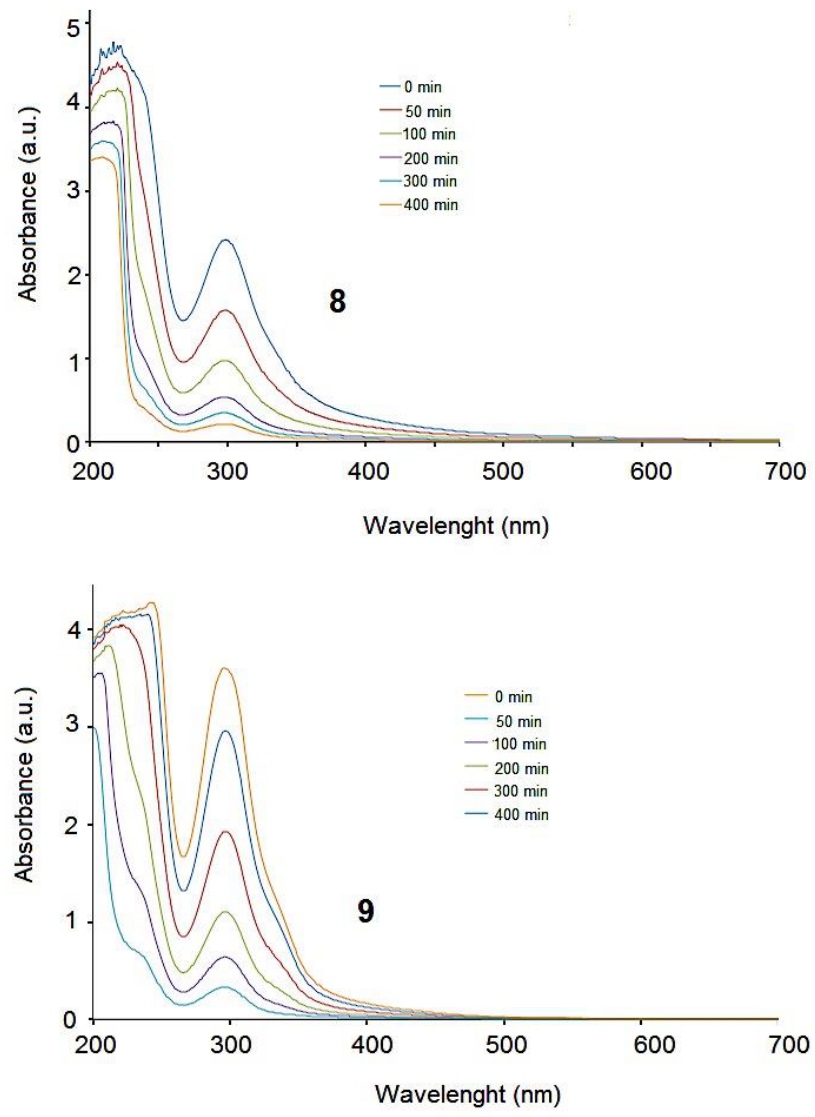
Figure 3. Ultraviolet (UV) spectra showing drug release from conjugates 8 and Figure 3 . Ultraviolet (UV) spectra showing drug release from conjugates 8 and 9.